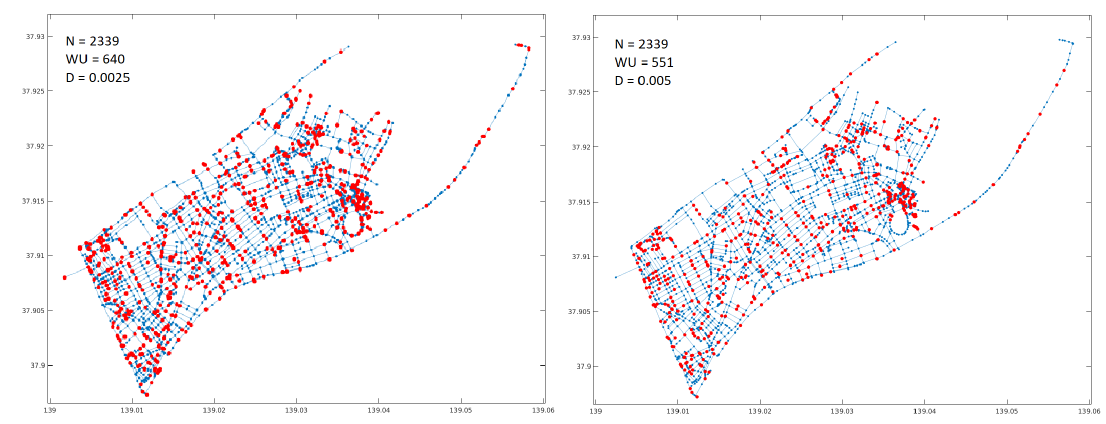
Figure 6. Solutions for the Niigata case. Left D = 0.0025, right D =